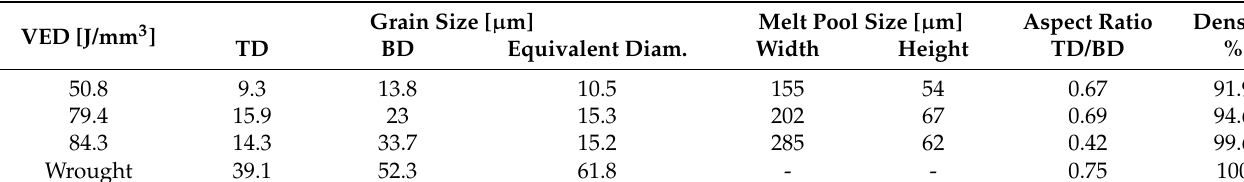
Table 3. Grain size, aspect ratio, and the measured density for AMed and wrought AISI 316L.